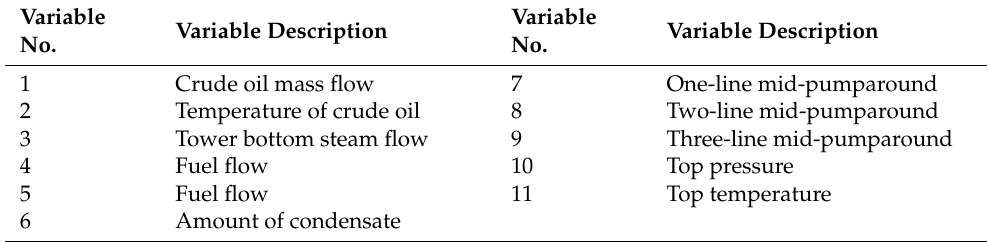
Table 8. Prediction parameters of vacuum two-line energy efficiency.